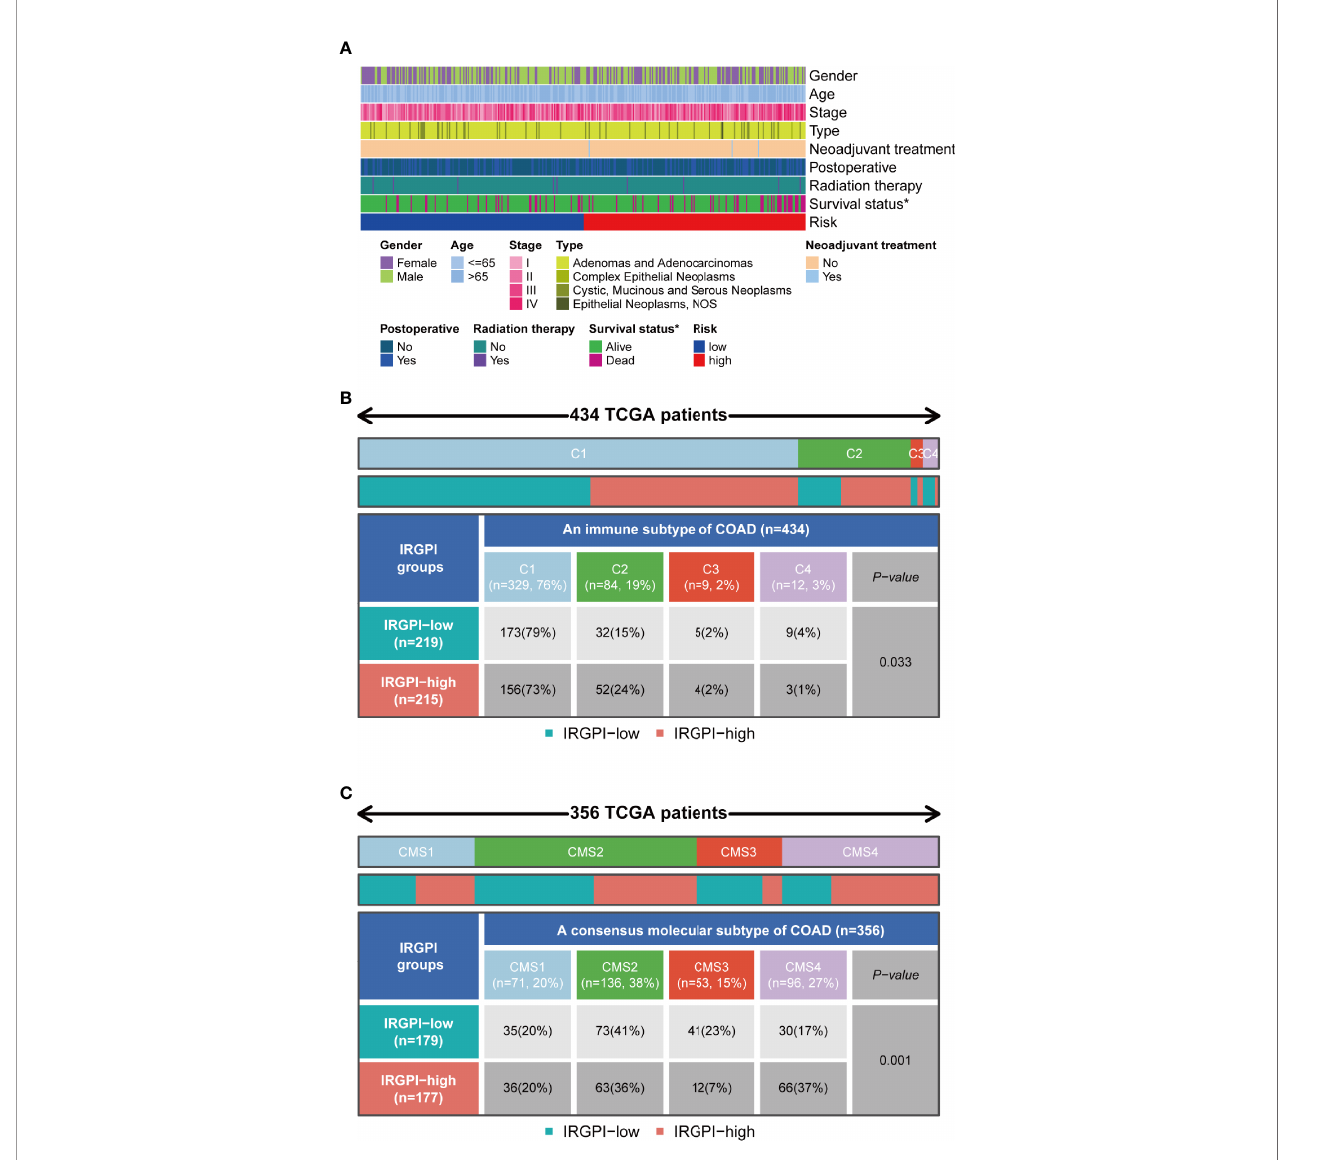
FIGURE 7 | Immunological and molecular subtype distribution of different IRGPI groups. (A) Heat map of IRGPI grouped clinical factors for colon cancer patients. (B) Heat map and table showing the distribution of colon cancer immune subtypes (C1, C2, C3, and C4) between the IRGPI groups. (C) Heat map and table showing the distribution of molecular subtypes (CMS1, CMS2, CMS3, and CMS4) between the IRGPI groups. IRGPI, immune-related gene prognostic index; CMS, consensus molecular subtypes. *P <